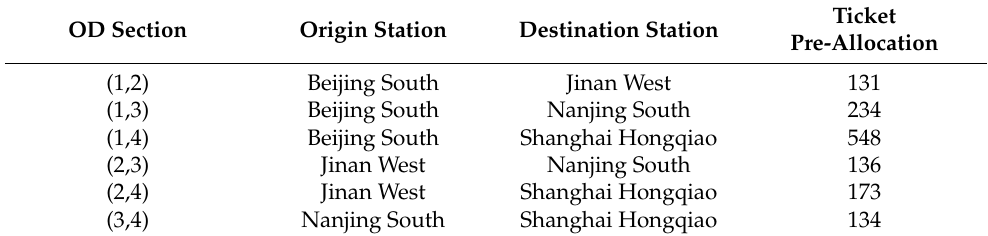
Table 2. Ticket pre-allocation scheme.